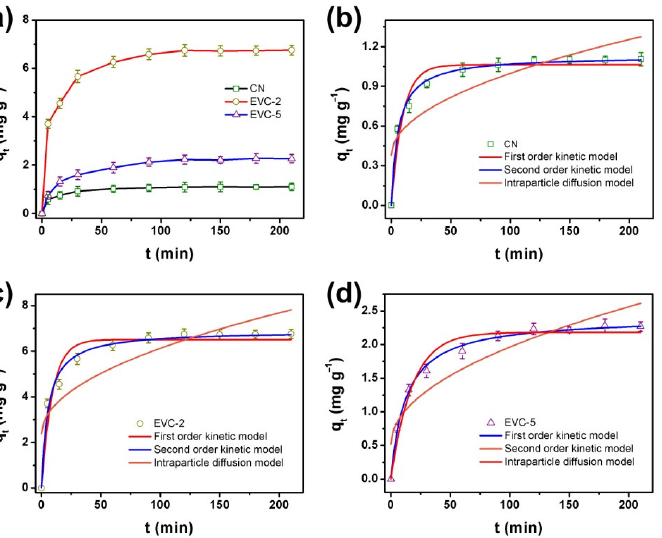
Figure 6. ( a ) The adsorption kinetic curves of MB (5 mg L − 1 ) on CN, EVC-2, and EVC-5: the first order, second-order, and intraparticle diffusion kinetics model for adsorption of MB on ( b ) CN, ( c ) EVC-2, and ( d ) EVC-5.